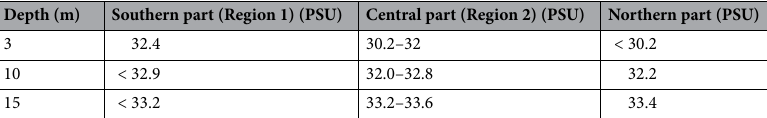
Table 1. Salinity versus depth in Tokyo Bay during Spring (collected from 34